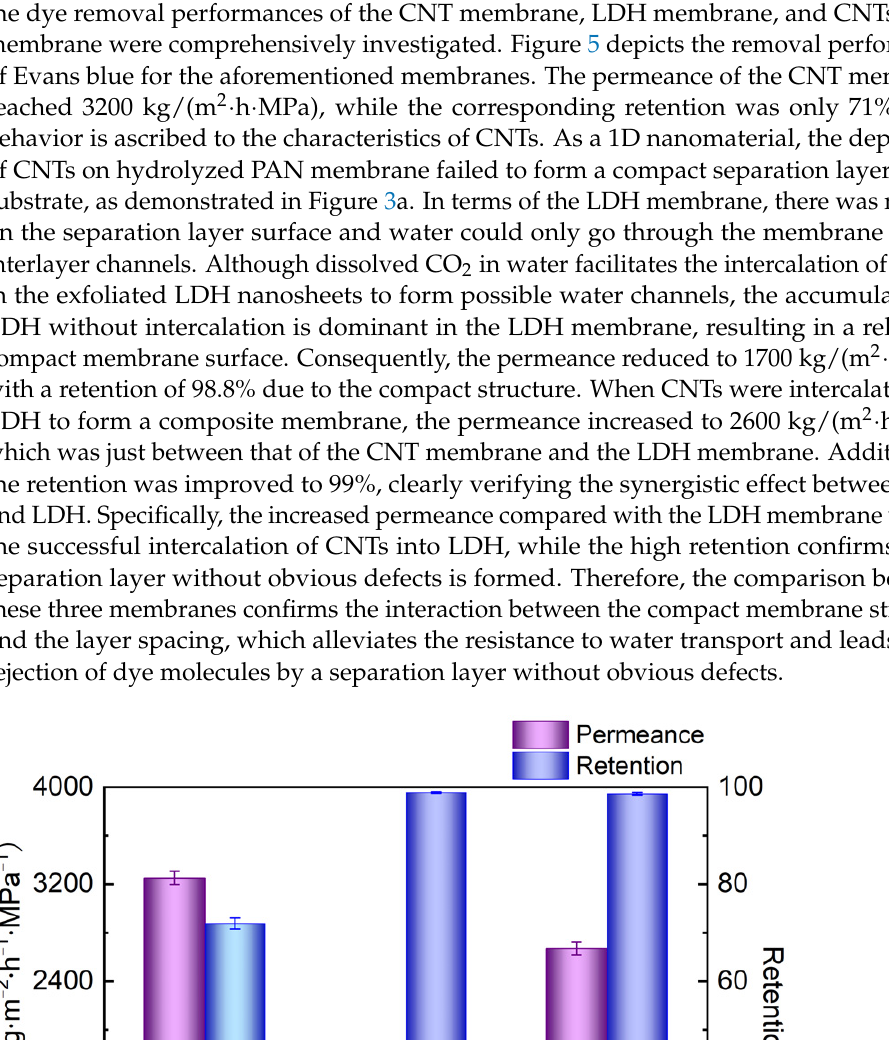
Figure 6. ( a ) The effects of CNTs concentrations on the separation performance (operation condition: 0.1 g/L Evans blue aqueous solution; operating pressure: 0.1 MPa); ( b ) the effects of LDH concen- trations on separation performance (operation condition: 0.1 g/L Evans blue aqueous solution; op- erating pressure: 0.1 MPa). Besides the amount of CNTs in the composite membrane, the concentration of LDH solution is crucial to the separation performance of the membrane. Figure 6b depicts the influence of the concentration of the LDH solution on the filtration performance of the obtained membranes. The permeance of the obtained membrane increased from 1685 to 2600 kg/(m 2 ·h·MPa) along with the increase in LDH concentration from 0.05 to 0.1 g/L. This growth of permeance can again be ascribed to the relative addition ratio between